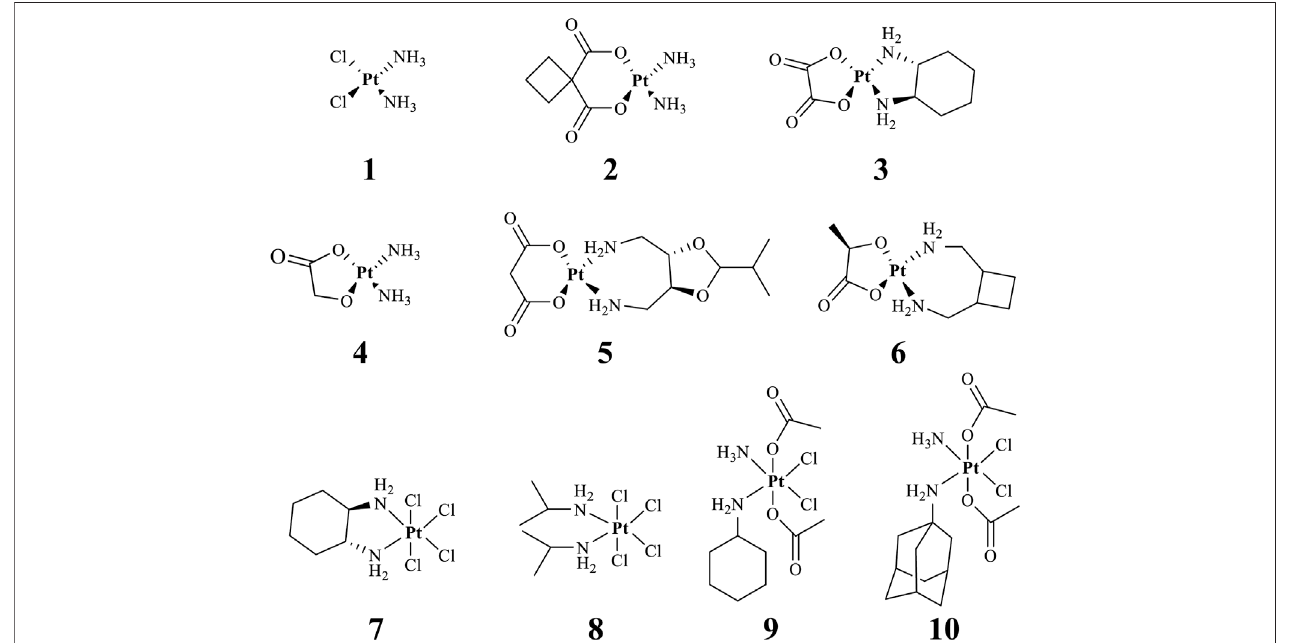
FIGURE 1 | Chemical structures of anticancer Pt( Ⅱ ) drugs in clinical use ( 1 – 6 ) and Pt(IV) prodrugs entering clinical trials ( 7 – 10) .